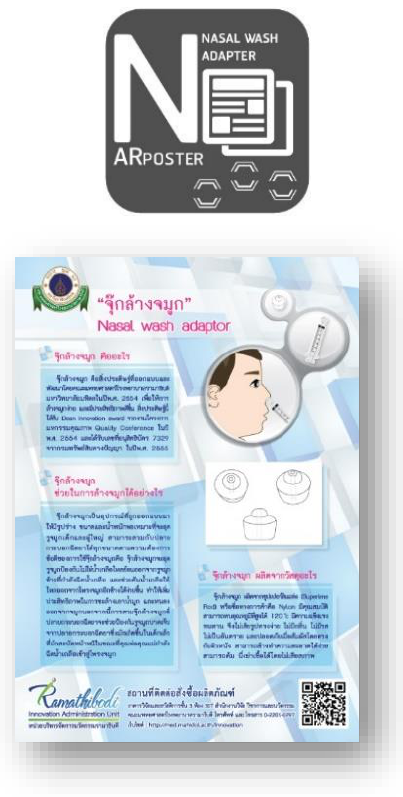
Figure 6 . The nasal wash AR code for infographic